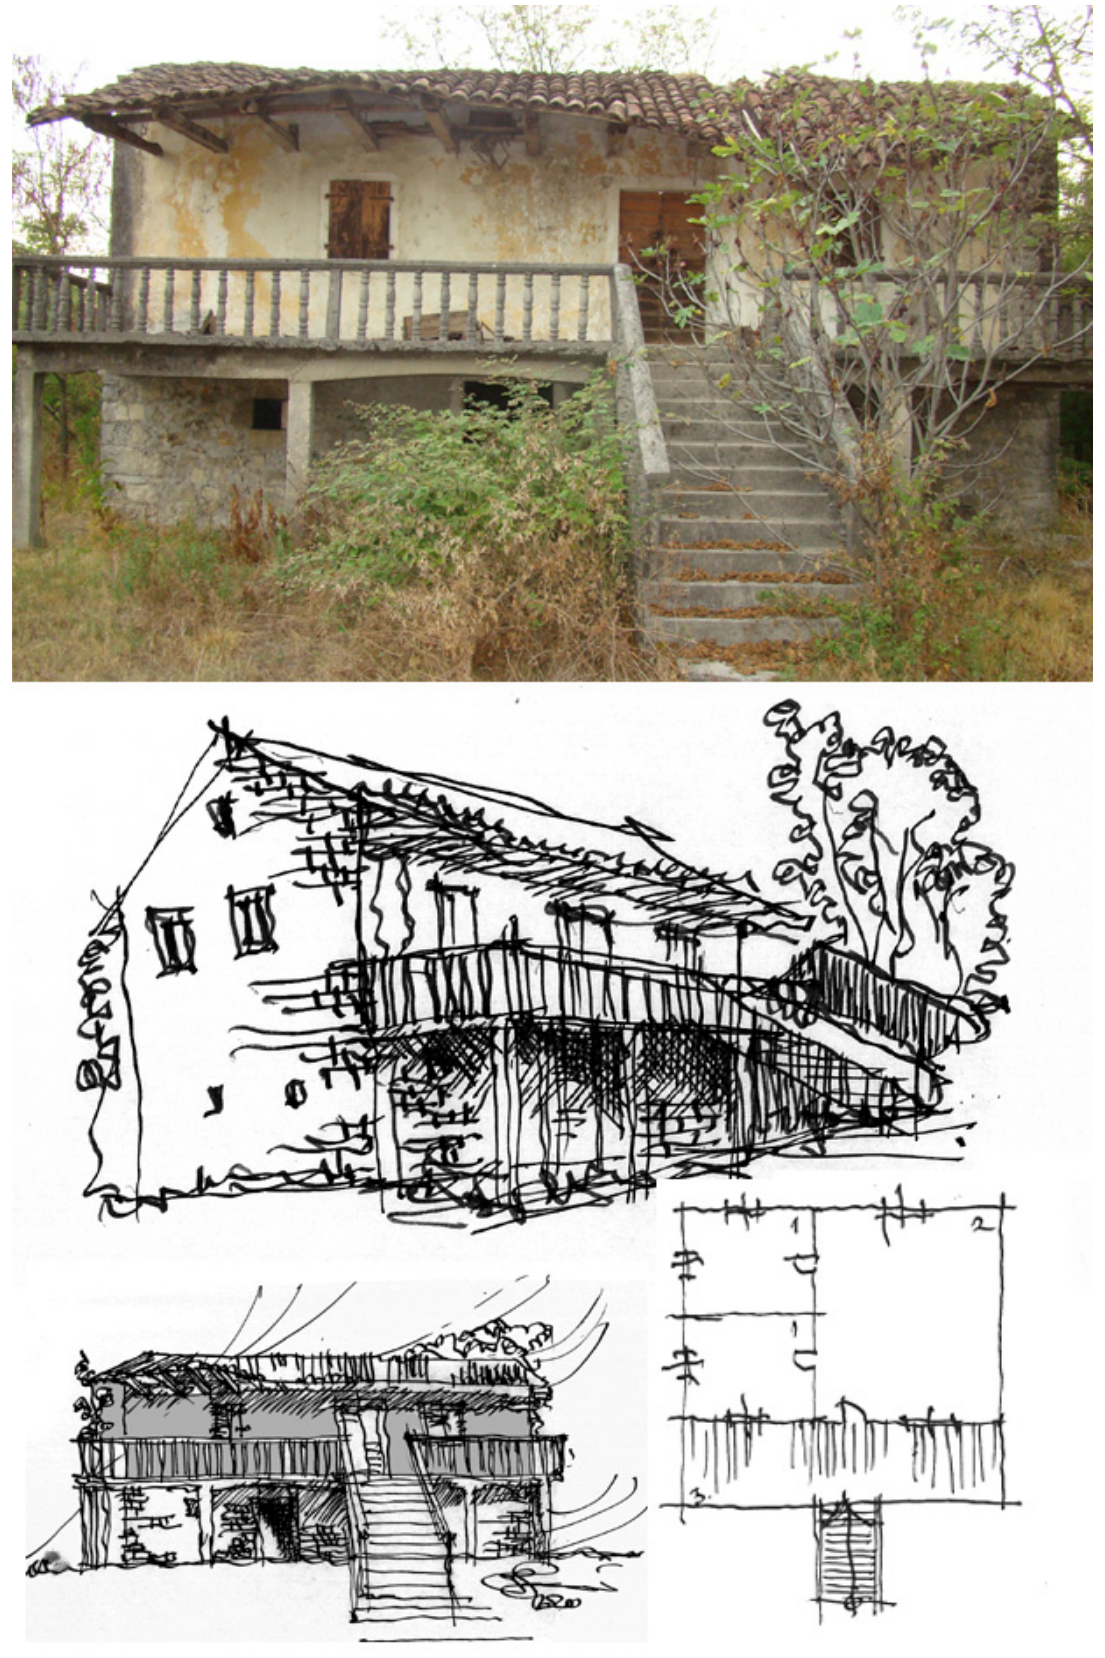
Figure 19. Photo and drawing of the House of Vukcevic, Zeta region (Photo G. Skataric).